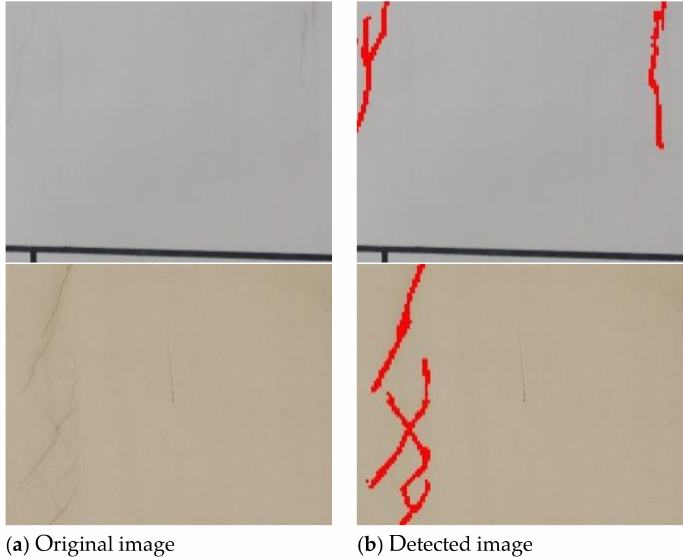
Figure 13. Detection results of different cracks.